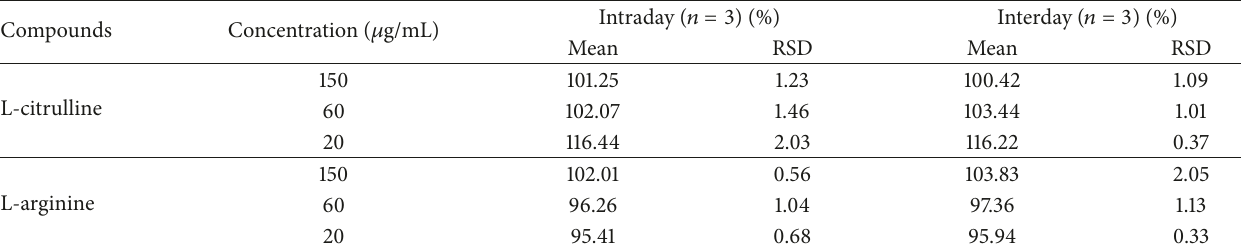
Table 4: Intraday and interday analysis of L-citrulline and L-arginine standard reported from isocratic RP-HPLC method.